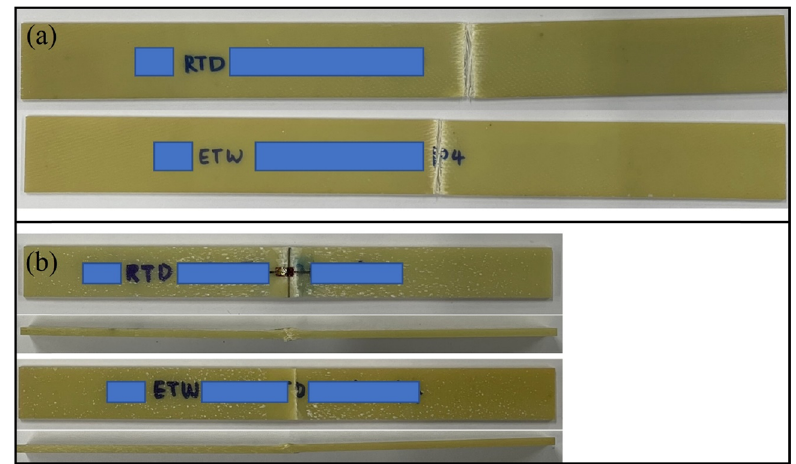
Figure 4: Failure mode of ( a ) tensile and ( b ) compression test specimens.